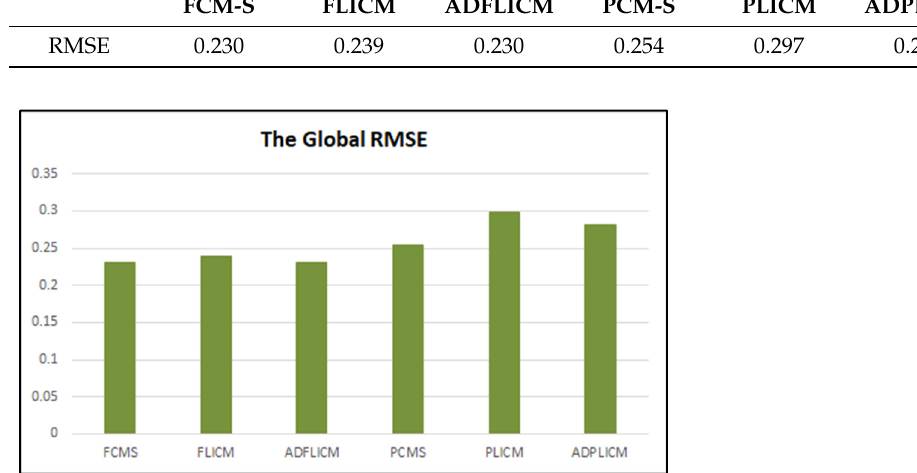
Figure 13. Global RMSE values for fuzzy local spatial information classifier outputs.